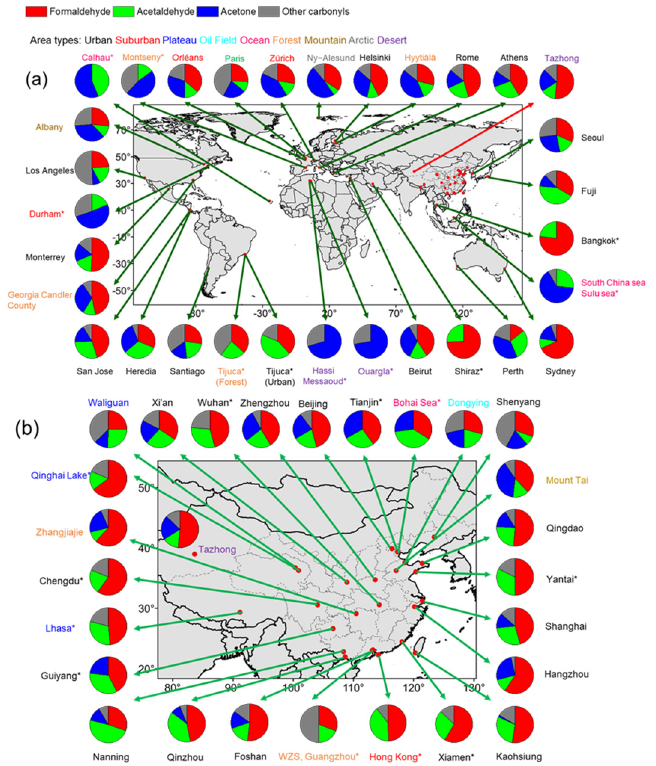
Figure 6. Summary of major carbonyl component (formaldehyde, acetaldehyde, acetone, other car- bonyls) compositions worldwide ( a ) and in China ( b ). Pie chart colors indicate carbonyl components, and name colors indicate different environments. * Indicates that some species were not meas- ured. See Table S3 for detailed information.